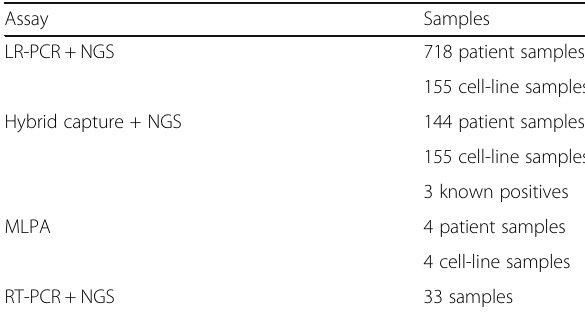
Table 1 Summary of samples